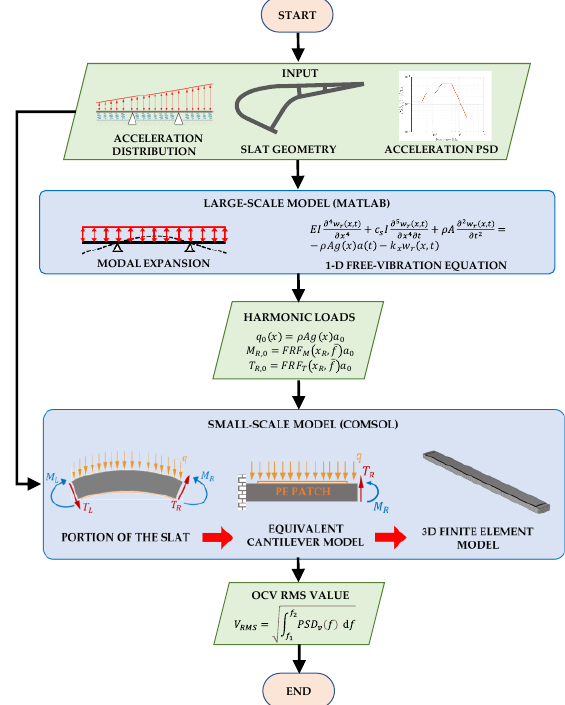
Figure 5. Scheme of the analytical – numerical method.